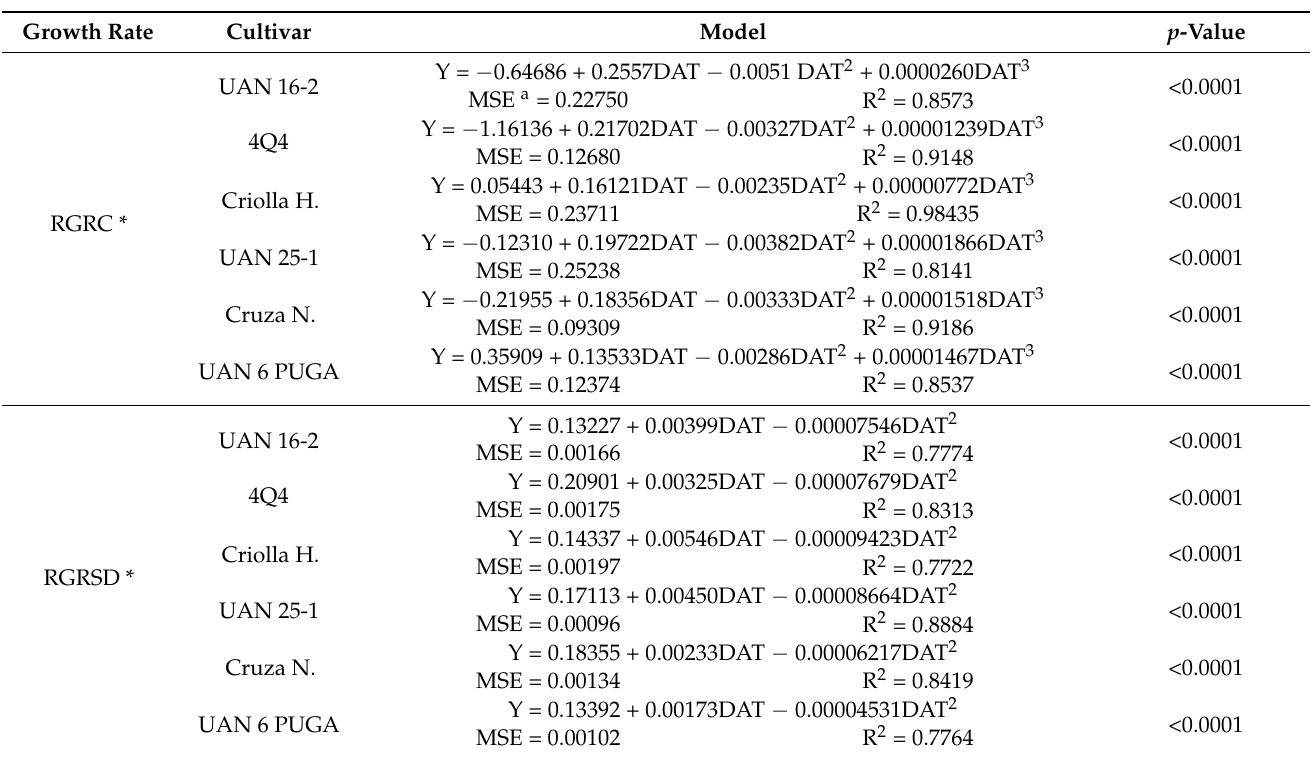
Table 1. Best-fit models of growth rates for the roselle cultivars cultivated hydroponically in a greenhouse.